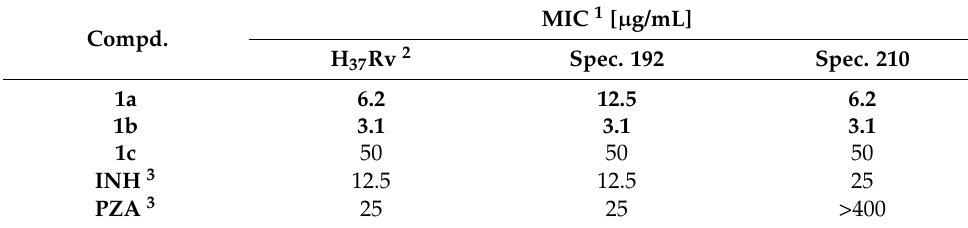
Table 2. In vitro tuberculostatic activity of compounds 1a–c 1,2,3 . Compd.